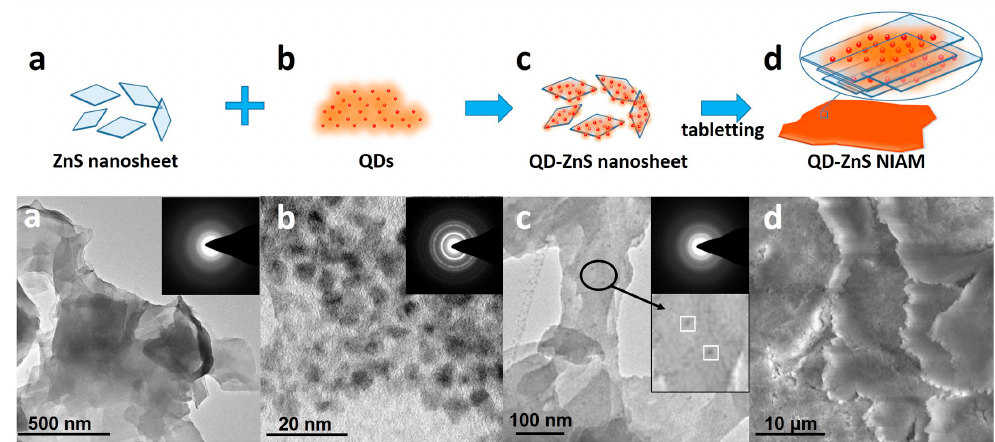
Figure 1. Illustration of the preparation procedure for the QD-ZnS nanosheet inorganic assembly monolith (QD-ZnS NIAM) and the TEM images of ( a ) the ZnS nanosheet; ( b ) QDs; ( c ) QD-ZnS nanosheet and ( d ) the SEM image of the QD-ZnS NIAM.